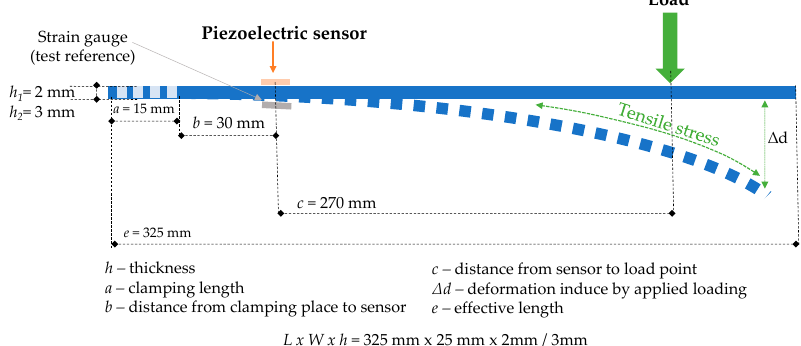
Figure 1. Schematic representation and characteristics dimension of the smart structure specimens.